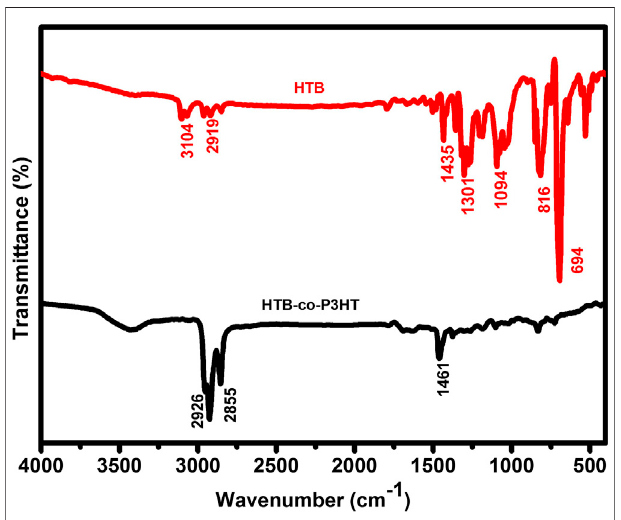
FIGURE2| FTIRspectraofHTB(redline)andHTB-co-P3HT(blackline).